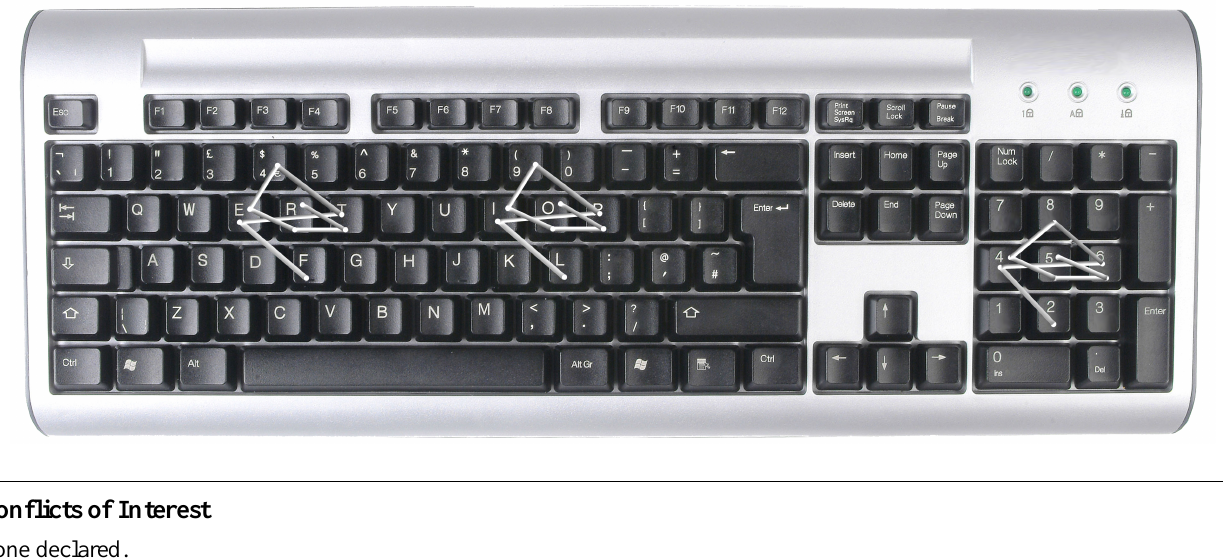
Figure 2. Another sequence to generate other passwords (about 15 minutes to memorize the